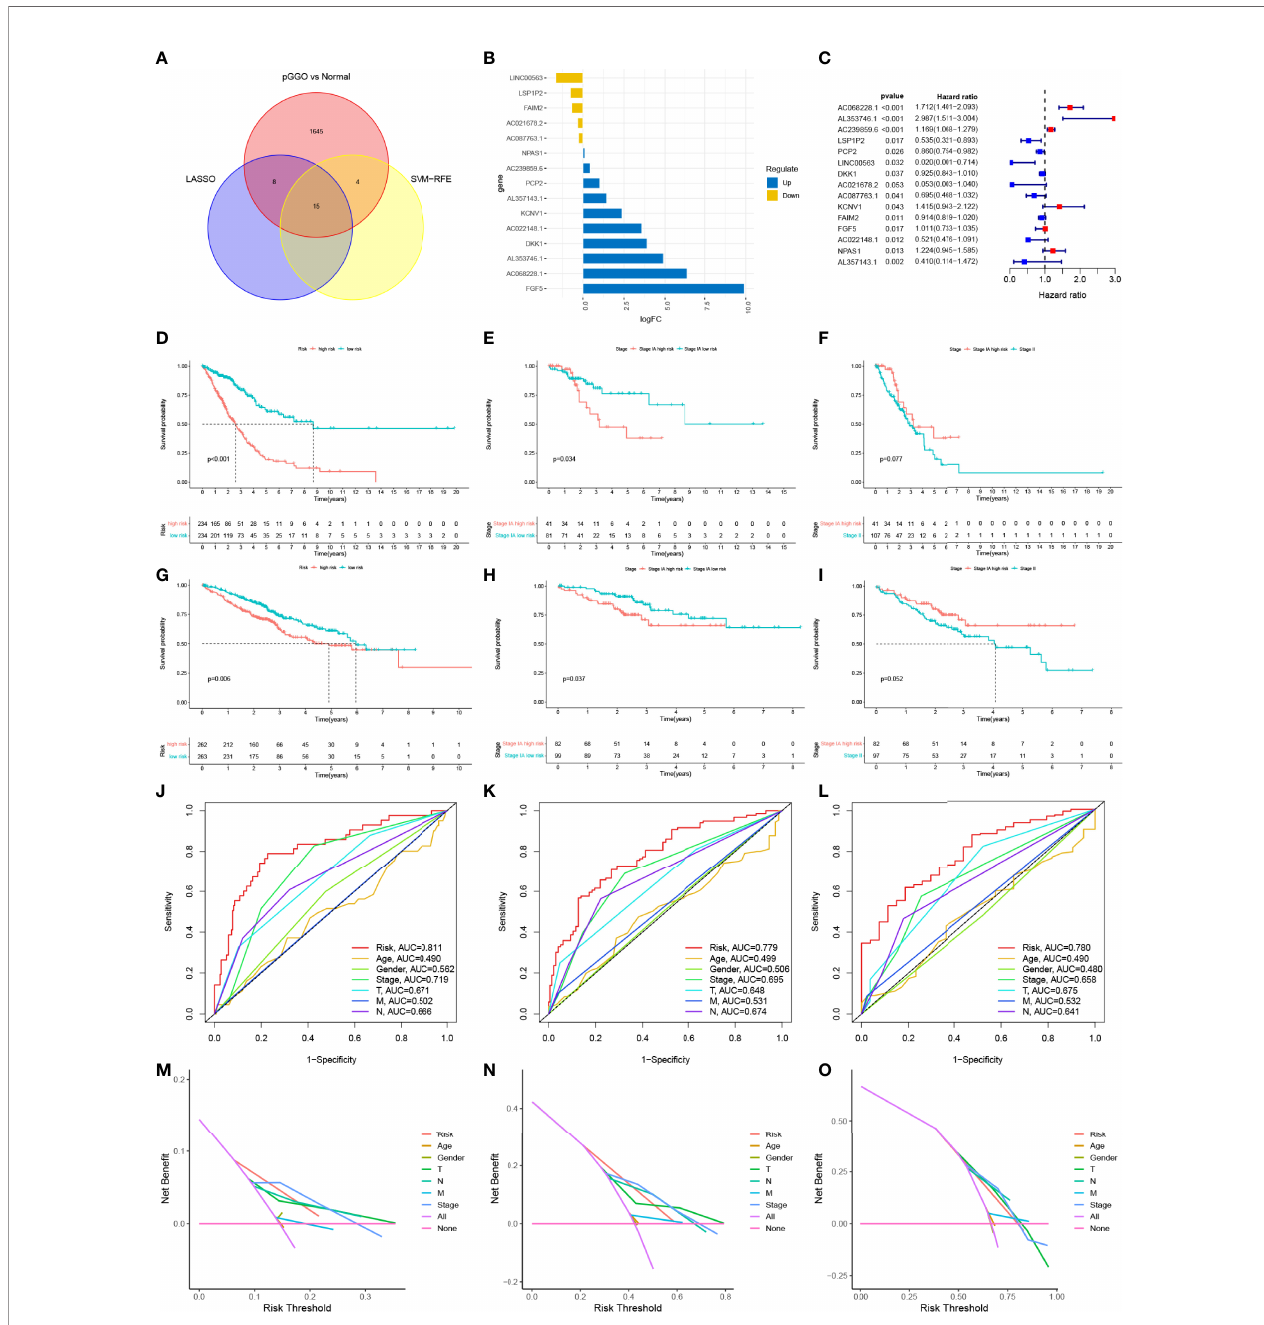
FIGURE 3 | The construction and veri fi cation of the risk signature. (A) Venn analysis was used to identify 15 DEGs that were shared between the machine learning algorithms (Lasso cox regression and SVM-RFE); (B) Expression data of the 15 prognostic pGGO-related DEGs; (C) Forest plot of the 15 prognostic pGGO-related DEGs (red: risk factors; blue: protective factors); (D – I) Kaplan – Meier survival curves. The TCGA-LUAD cohort was strati fi ed into a high-risk group and low-risk group. Patients in the high-risk group had a worse prognosis than the patients in the low-risk group in the overall TCGA-LUAD cohort (D) and patients with Stage IA LUAD (E) . There was no signi fi cant difference in OS between patients with Stage IA LUAD and high-risk scores and patients with Stage II LUAD (F) . Patients with LUAD from the GSE50081 and GSE72094 datasets were strati fi ed into a high-risk group and low-risk group. Patients in the high-risk group had a worse prognosis than the patients in the low-risk group in the overall GEO-LUAD dataset (G) and patients with Stage IA LUAD (H) . There was no signi fi cant difference in OS between patients with Stage IA LUAD and high-risk scores and patients with Stage II LUAD (I) . (J – L) R Time-dependent ROC curve analysis at 1 (J) , 3 (K) , and 5 years (L) veri fi ed the predictive performance of the 15-gene risk signature in the TCGA-LUAD cohort. (M – O) DCA at 1 (M) , 3 (N) , and 5 years (O) veri fi ed the predictive performance of the 15-gene risk signature in the TCGA-LUAD cohort. DEGs, differentially expressed genes; GGO, ground-glass opacity; ROC, receiver operating characteristic; LUAD, lung adenocarcinoma; SVM-RFE, support vector machine — recursive feature elimination; DCA, decision curve